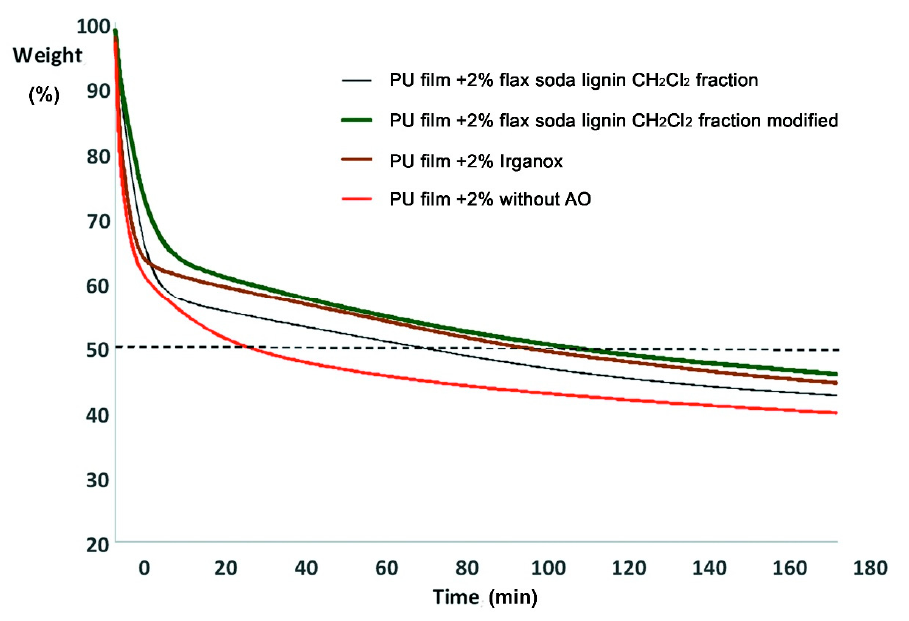
Figure 9. Kinetics of the thermooxidative degradation of polyurethane (PU) films (with and without addition of antioxidant).